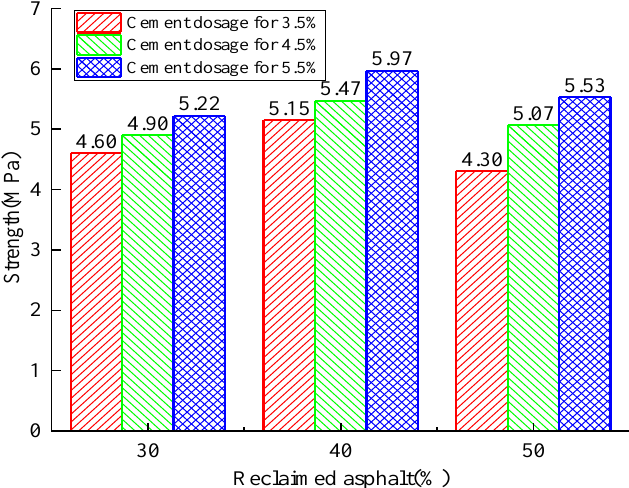
Figure 8. Analysis of the 7-day axial compressive-strength test with variation of cement dosage and RAP.